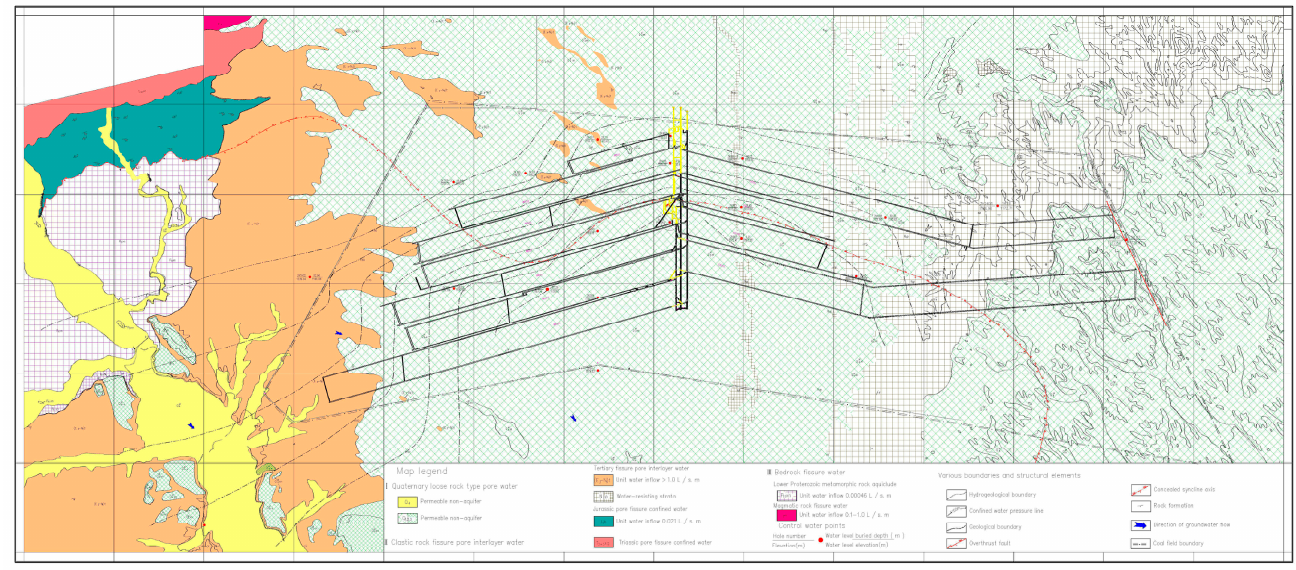
Figure 3. Map of the groundwater flow.